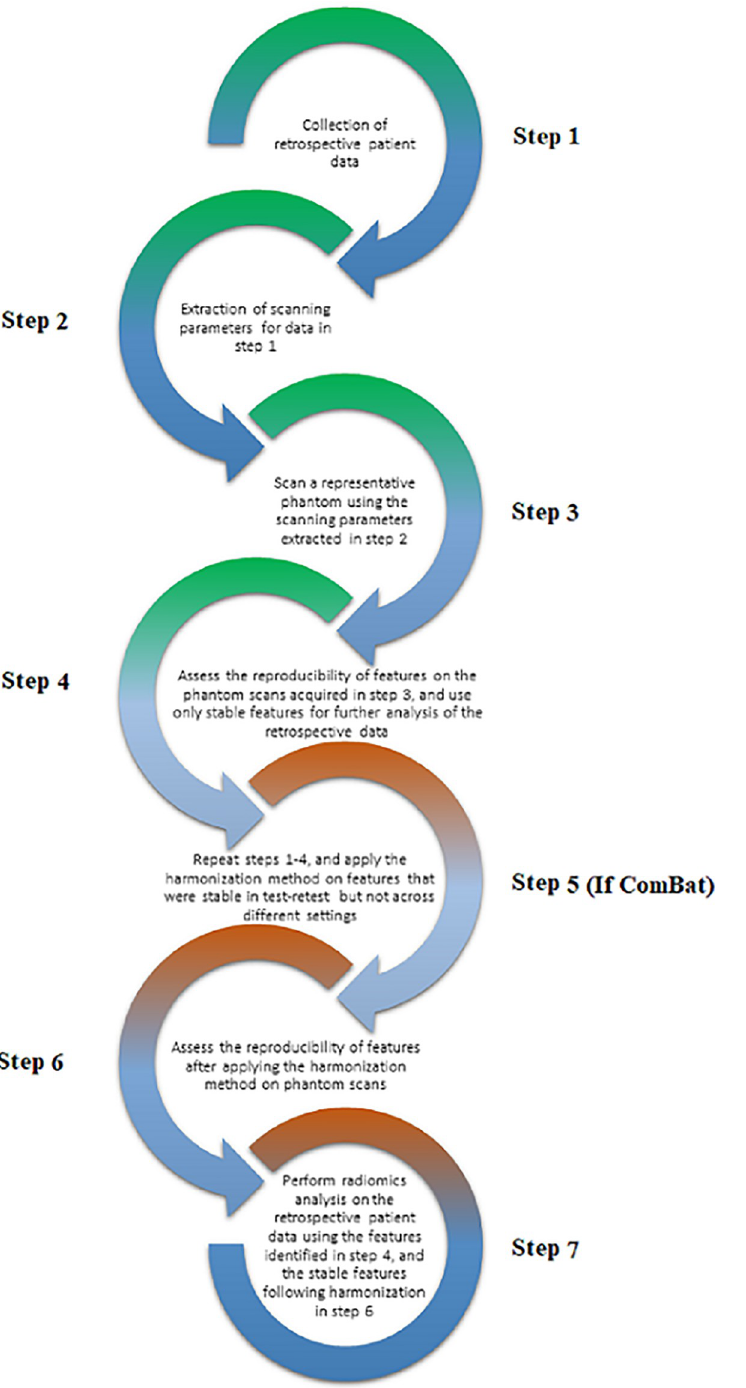
Fig 1. The proposed framework (reprinted with permission from